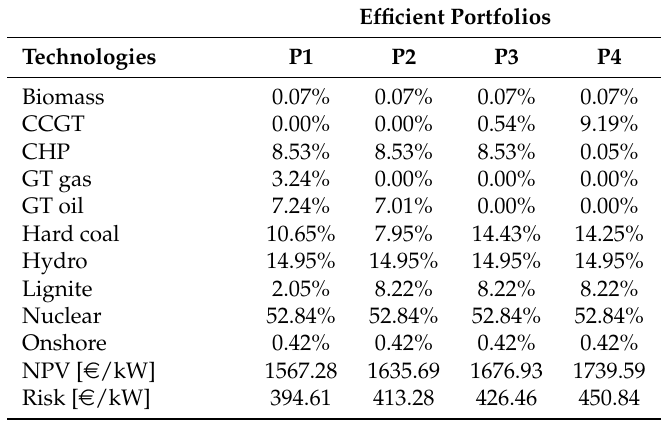
Table A5. Efficient portfolios according to FSMAD Model 3 for existing technologies.